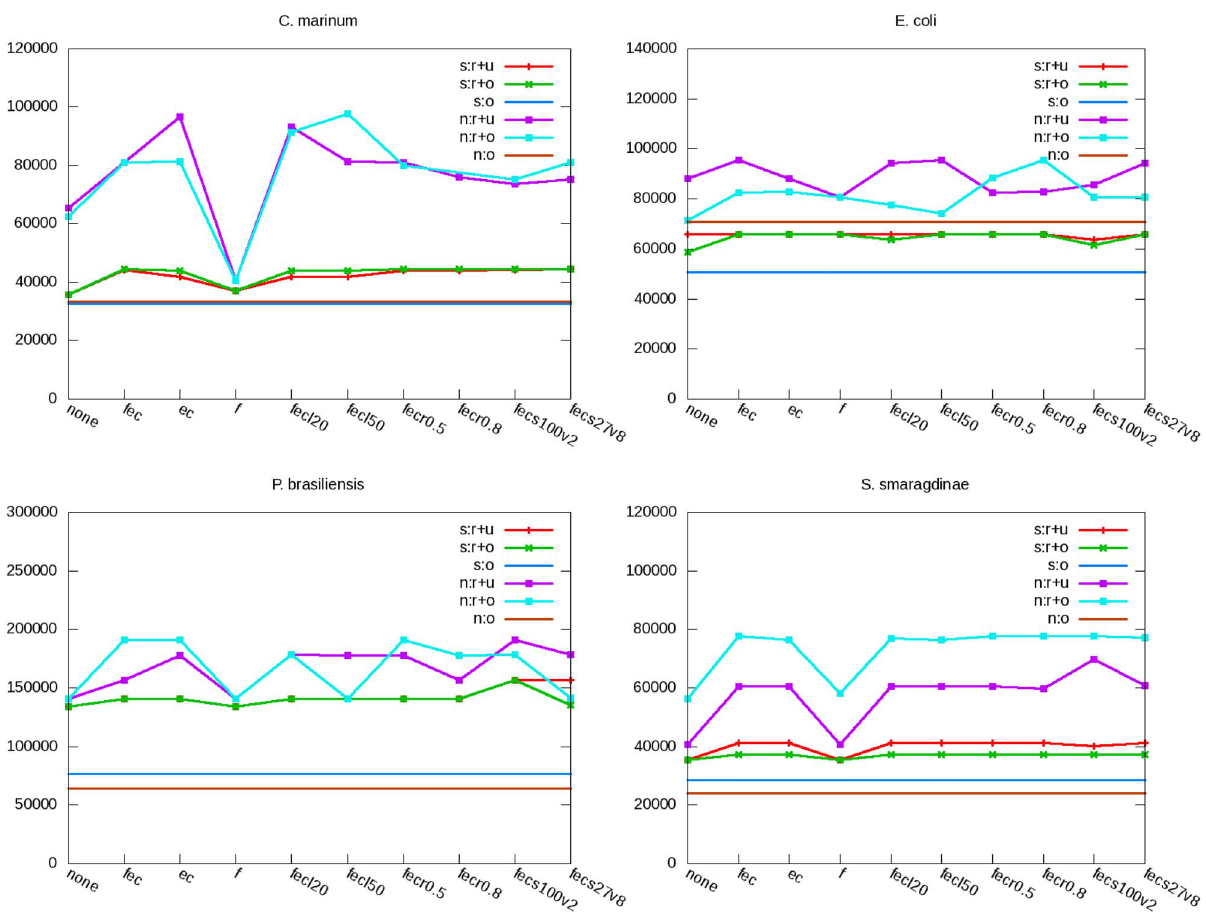
Figure 4. Effects of ARF-PE parameters on genome assembly. SOAPdenovo (s) and Newbler (n) are used to assemble the recovered DNA fragments (r) together with the remaining (u) and original (o) PEs of four bacteria. X-axis indicates the combinations of parameter values defined in Figure 3. Y-axis shows the corrected N50 length when three types of data are assembled.